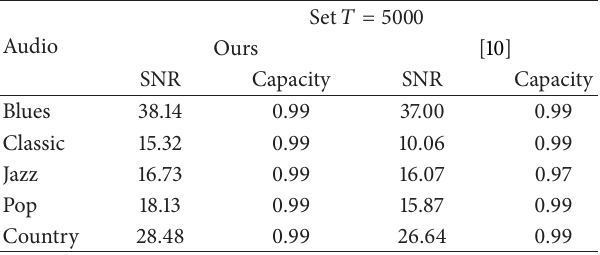
Table 2: The comparison of SNR and capacity between embedded audio using the optimal linear prediction coefficients and best linear prediction coefficients proposed in